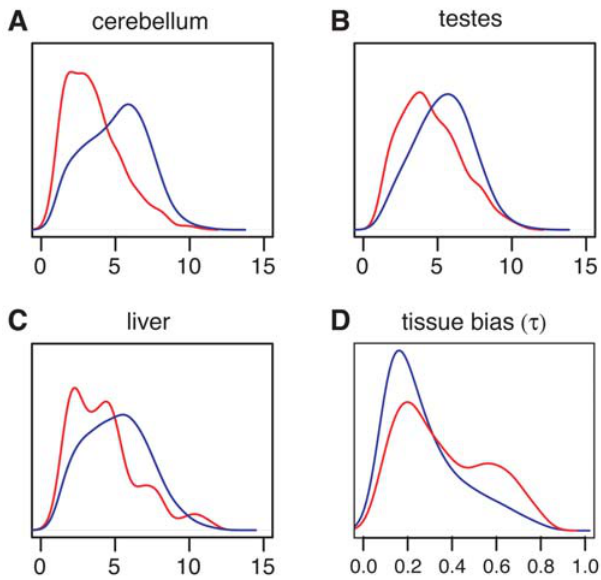
Figure 5. Distributions of expression levels in PSGs (red) and non-PSGs (blue) for three tissue types. (A–C) Distributions as estimated from Affymetrix Human Exon 1.0 ST Array data by the RMA algorithm [88]. The other eight tissue types showed similar differences between PSGs and non-PSGs (Figure S7). (D) Distribution of degree of tissue bias in expression levels for PSGs (red) and non-PSGs (blue), as measured by the statistic t [61] (Methods). An alternative measure of tissue bias ( c ) showed a similar pattern.